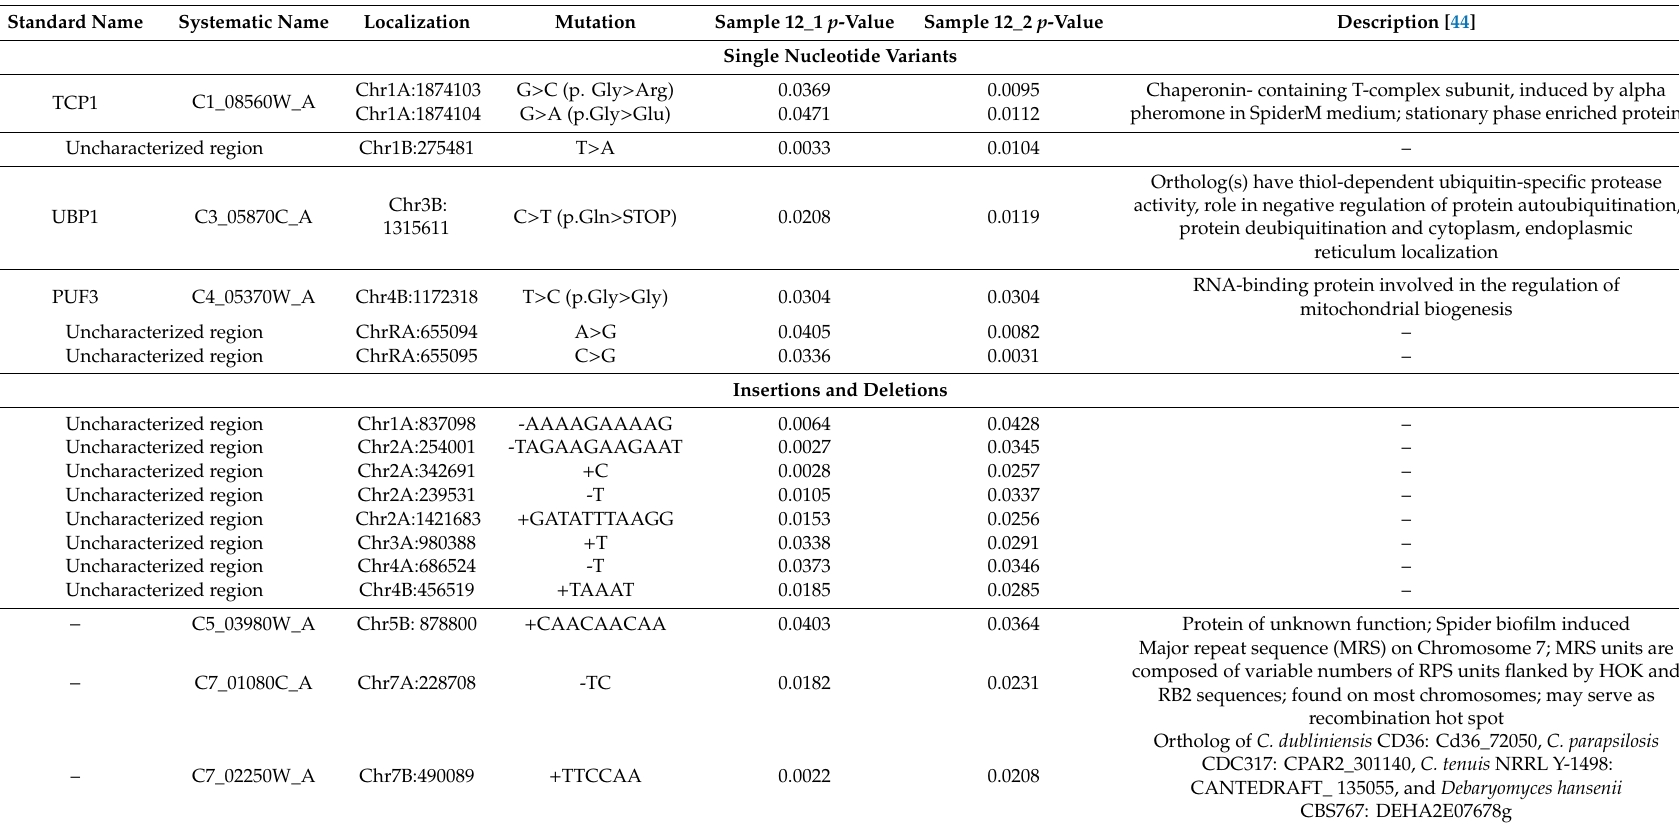
Table 1. Summary of statistically significant mutations detected in the tested